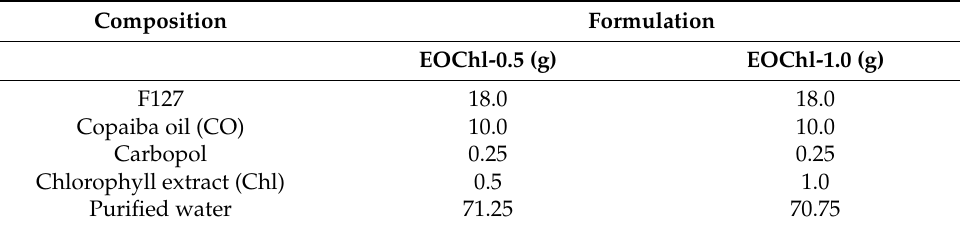
Table 1. Dermatological gel composition for 100